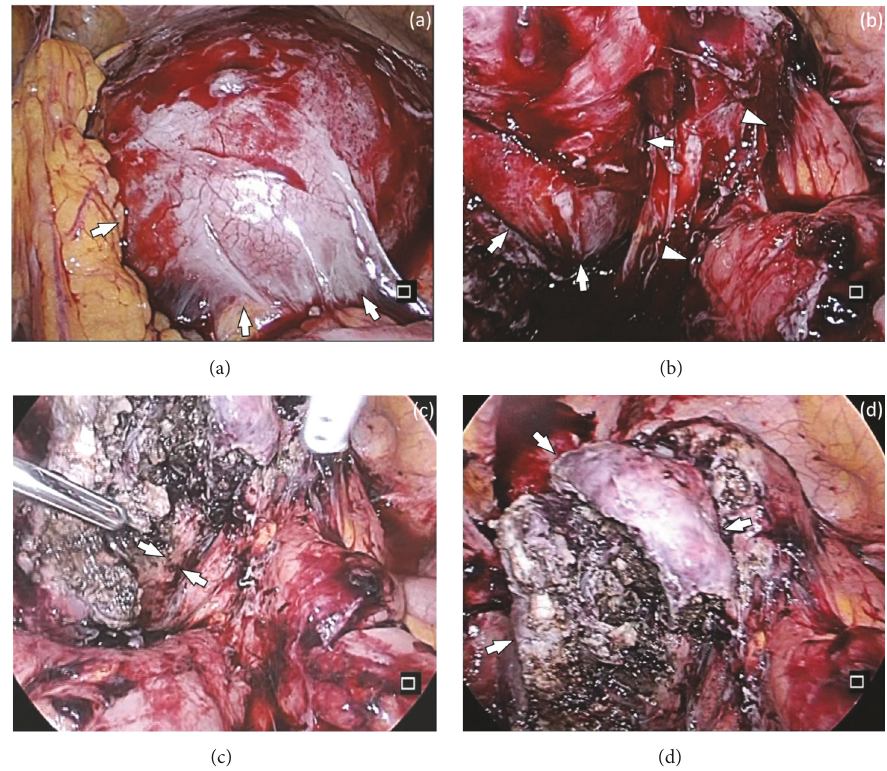
Figure 3: Laparoscopic views during the surgery. (a) The left ovary was swollen to 10 cm (arrows). (b) The uterinewas firmly adhered with the left adnexa (arrows) and retroperitoneum (arrowheads). (c) The left ureter (arrows) was identified visually by moving the catheter manually back and forth from outside the body. (d) The left ovarian cyst was excised, leaving the normal part of the ovary